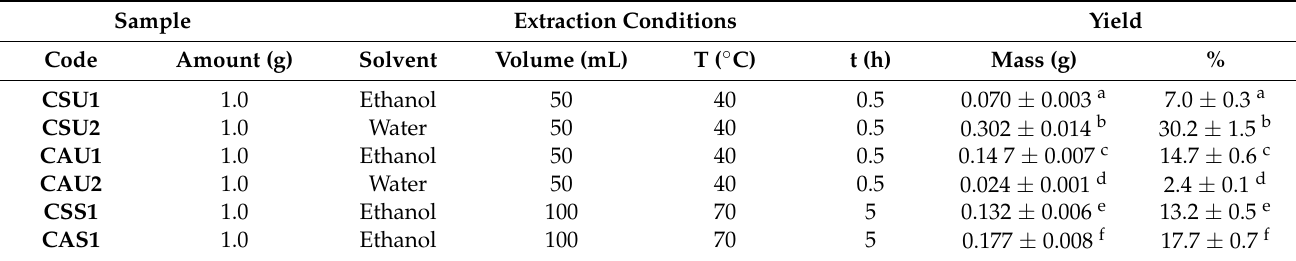
Table 1. Ultrasound-assisted and Soxhlet extractions of Carob Selvatica and Amele leaves.